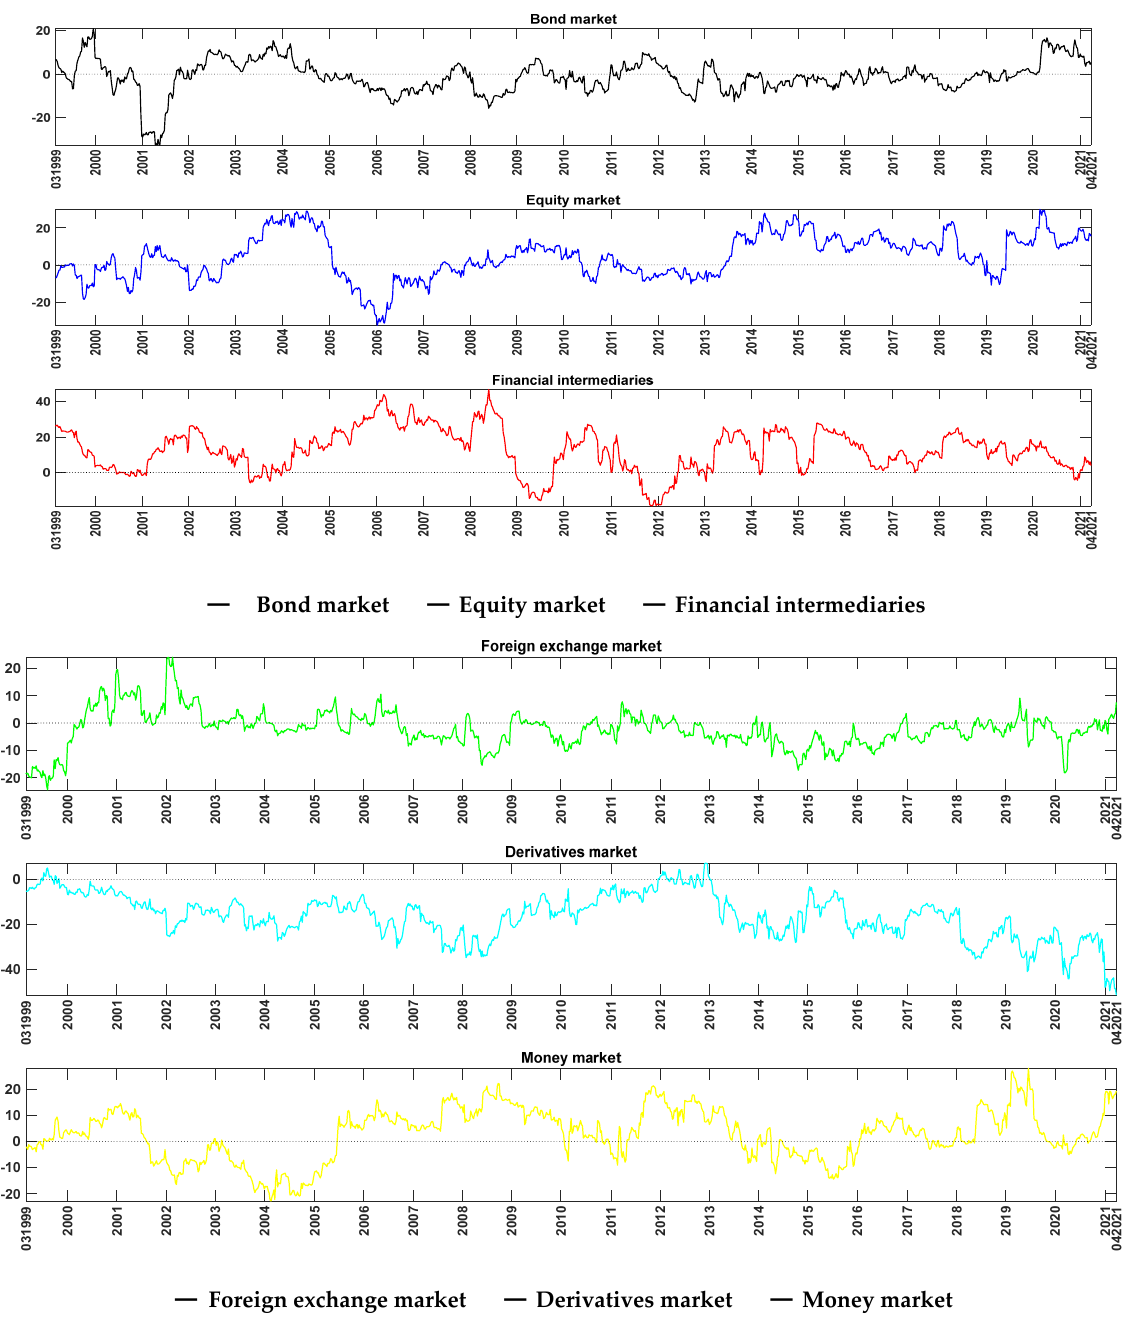
Figure 4. Net directional connectedness for stress indicators of the Spanish financial market.